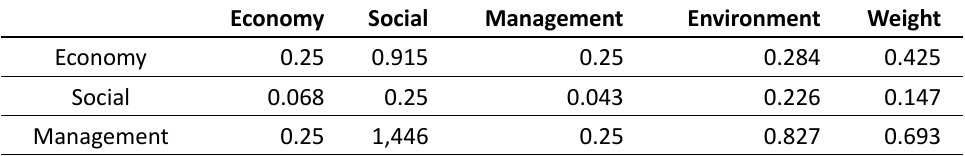
Table 7. The Results of The Joint Priority Values